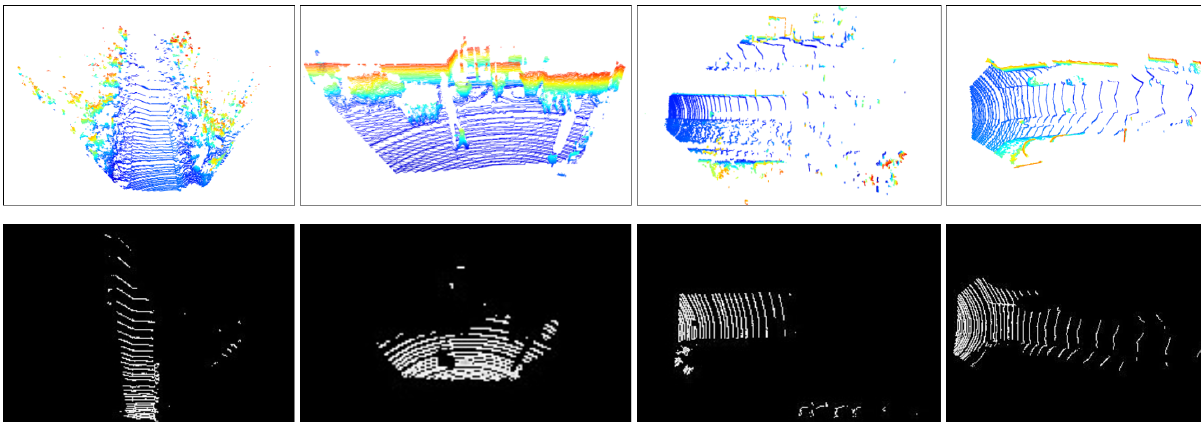
Figure 6. The visualization of candidate places generated by our group-based placing method (second row) and original point clouds (first row).